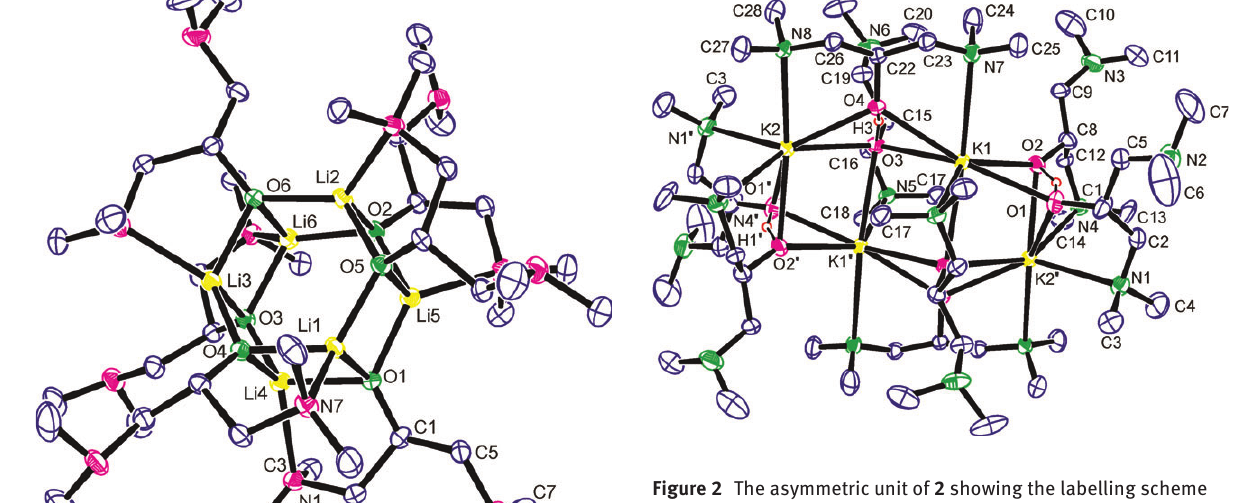
Figure 2 The asymmetric unit of 2 showing the labelling scheme used; thermal ellipsoids are at the 40% probability level. Selected metrical data: K(1)-O(1) 2.770(2), K(1)-O(2) 2.737(2), K(1)-O(3)